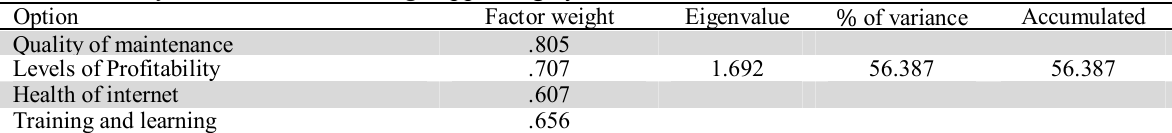
The summary of factors influencing supporting systems